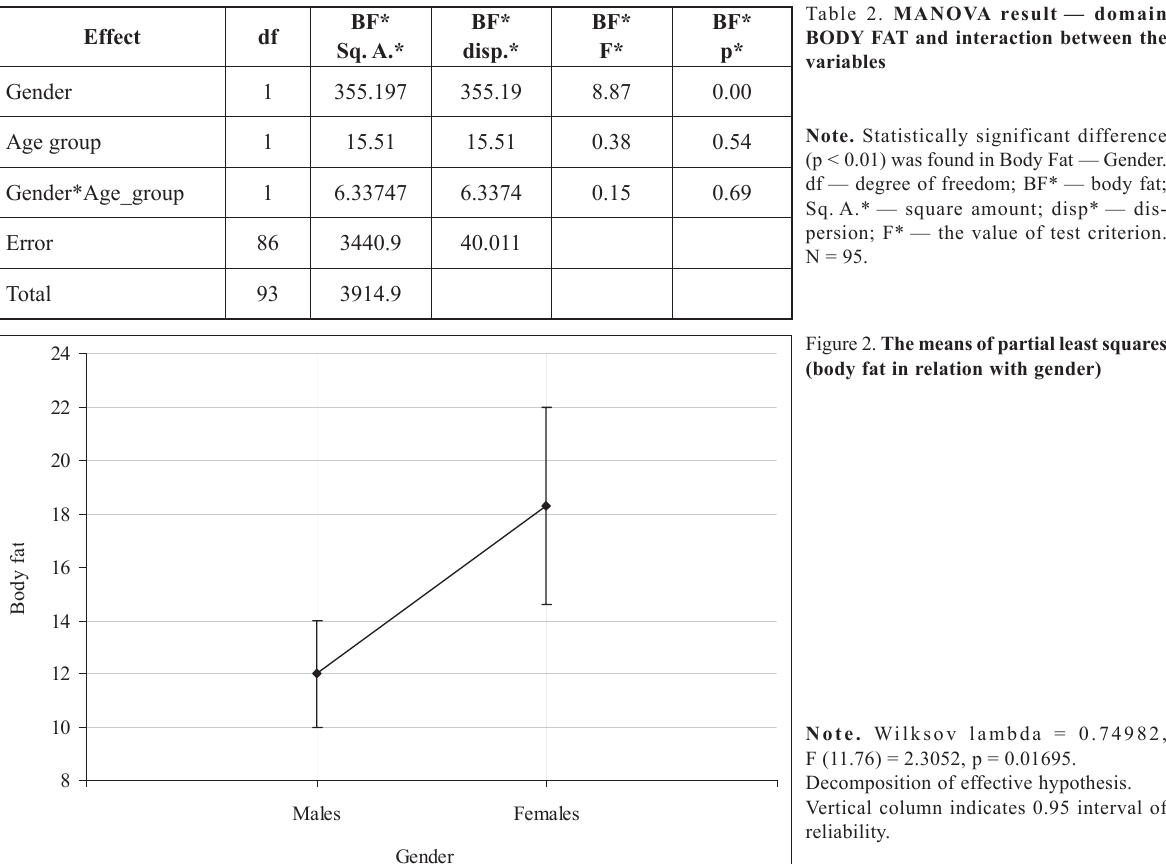
Note. Wilksov lambda = 0.74982, F (11.76) = 2.3052, p = 0.01695. Decomposition of effective hypothesis. Vertical column indicates 0.95 interval of